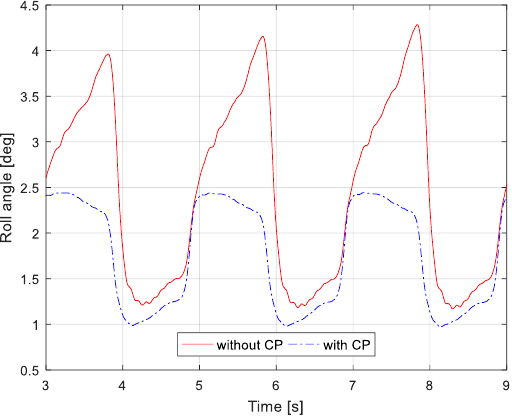
Figure 11. Measured orientation of pelvis with/without capture-point feedback on tilted ground. The orientation was measured from an inertial measurement unit mounted on the robot pelvis.